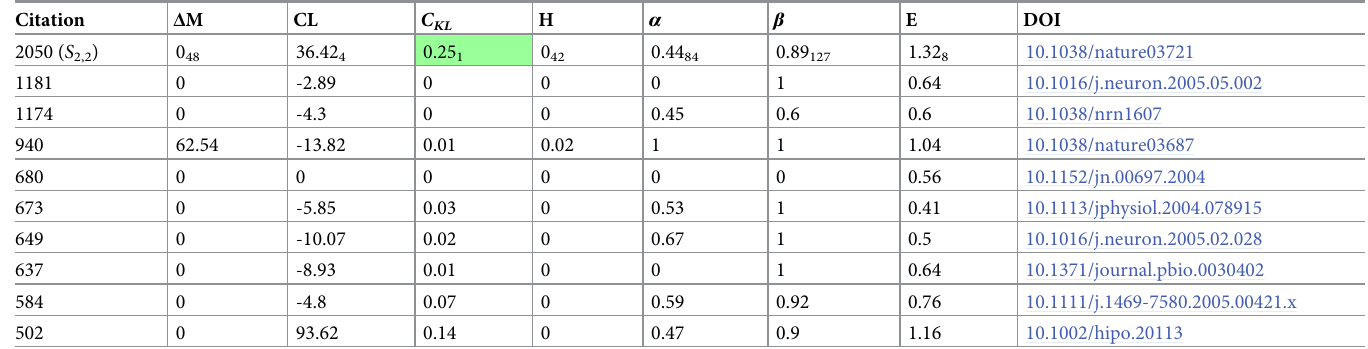
Table 6. Case 2. The SVA scores of top-10 citing papers in the network (2000-2005). SVA score ranges: Δ M :0.0–62.54, CL :-93.62–54.84, C KL :0.0–0.25, H :0.0–0.67, α :0.0– 1.0, β :0.0–1.0, E : 0.0–1.43. The subscript next to an SVA score of each seed paper indicates the paper’s relative rank according to that metric, sorted in a descending order. Citation